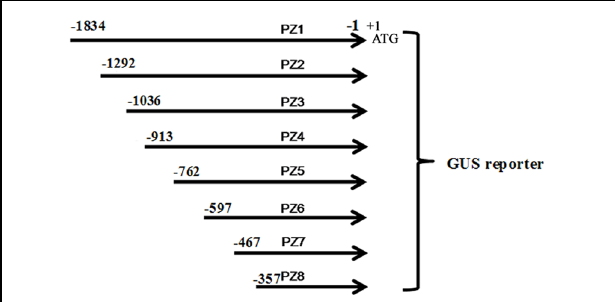
(Supplementary Figure S1). The homozygous transgenic lines of T3 generation with a single copy of promoter ::GUS insert were selected for subsequent analyses via segregation ratio